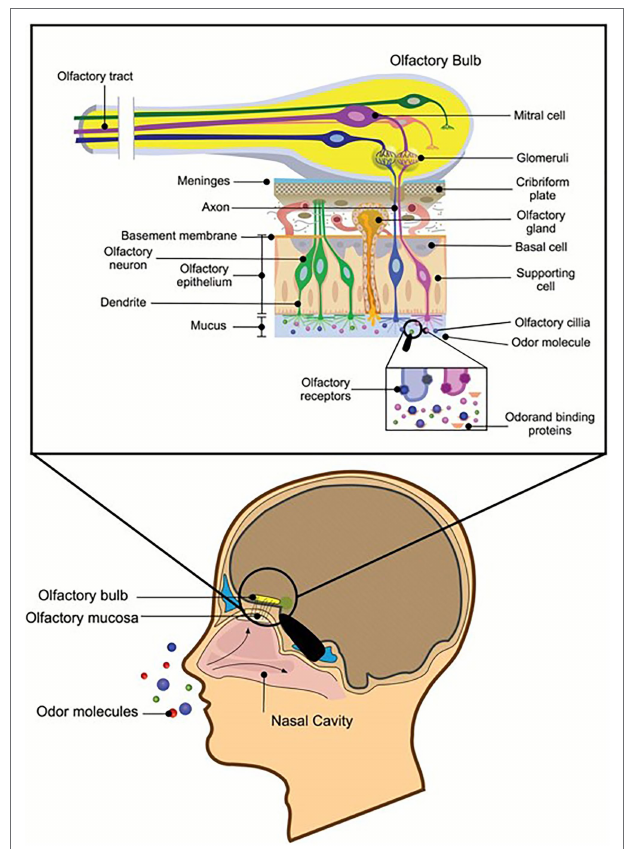
FIGURE 6 | Reprinted with the kind permission of Chemical Senses publications (Silva Teixeira et al., 2015). Schematic representation of a sagittal section through the human head with a section of the olfactory nervous system depicted in greater detail. Air transmits odor molecules to olfactory mucosa, combines with odor transporter proteins to form complexes, and transports them to olfactory receptors on olfactory cilia. After a series of signal transductions, they are transmitted to the olfactory tract to produce olfactory